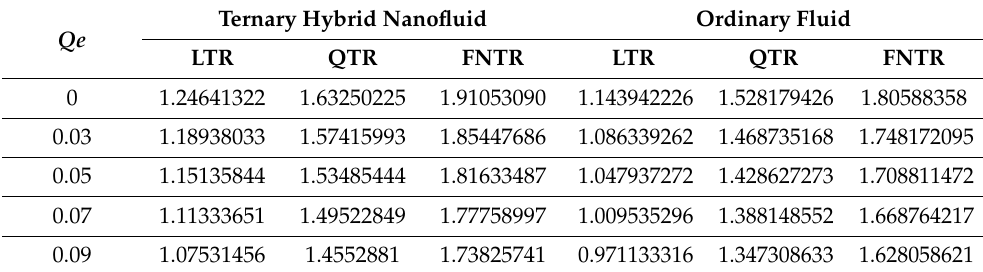
Table 6. Nur values versus Qe for the LTR, QTR, and FNTR cases.